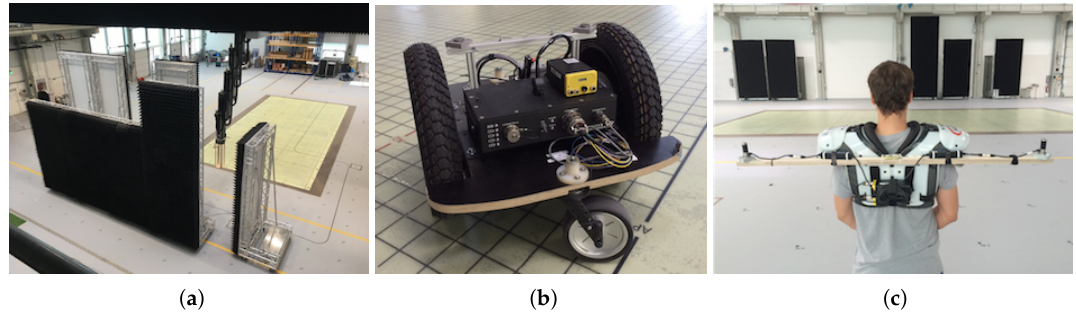
Figure 6. Platforms training data generation. ( a ) Positioning system [1]. ( b ) Segway. ( c )